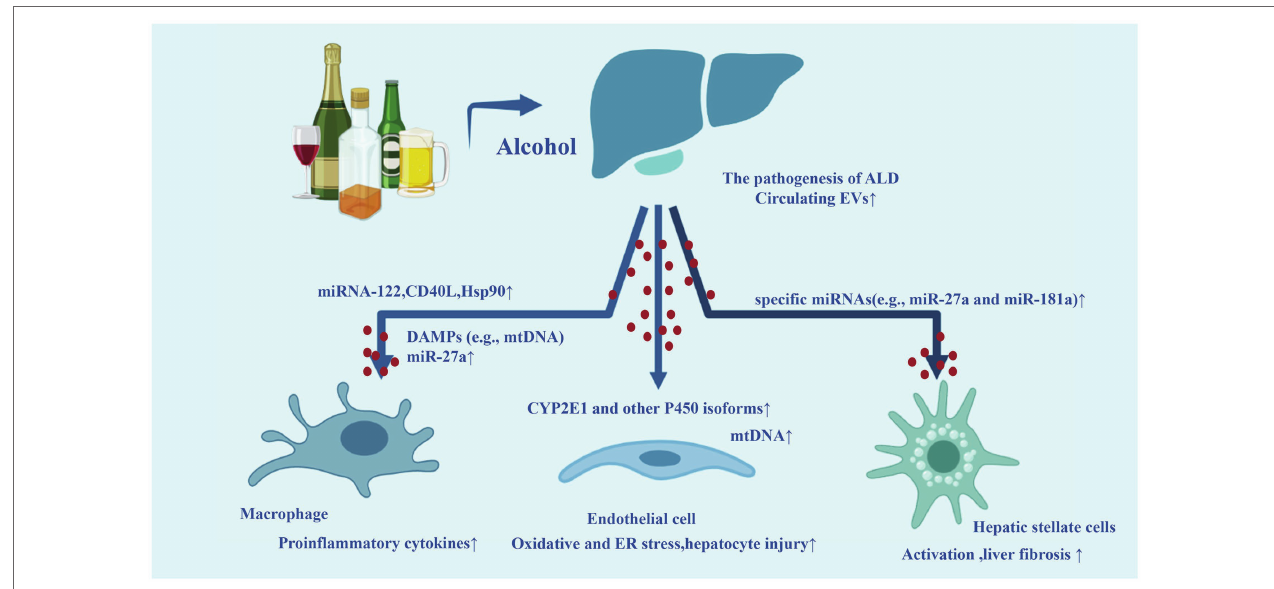
FIGURE 2 | Extracellular vesicles in the development of alcoholic liver disease (ALD). Alcohol exposure in the liver can increase the number of circulating EVs. Some biomolecules loaded by EVs are upregulated, acting on target cells [such as macrophages, endothelial cells, and hepatic stellate cells (HSCs)] and promoting inflammation and fibrosis. The release of circulating EVs containing a high level of these biomolecules is related to the progression of ALD to their inflammatory and more aggressive forms alcoholic steatohepatitis